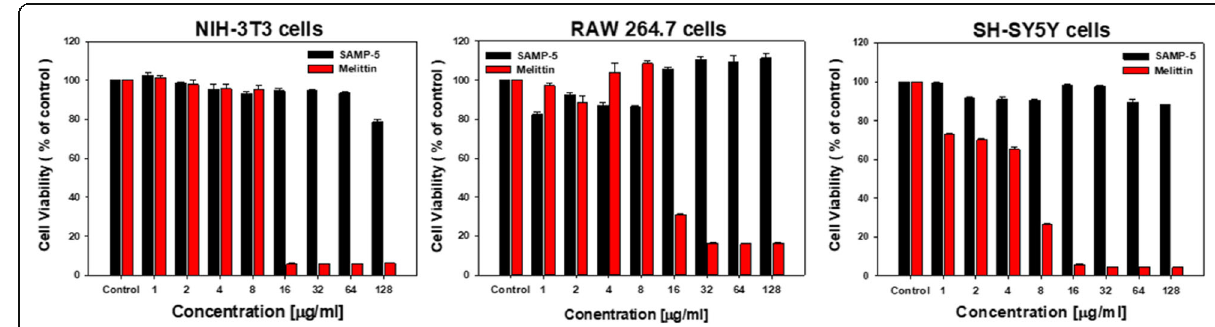
Fig. 2 Cytotoxicity of SAMP-5 against mouse embryonic fibroblast NIH-3T3 cells ( a ), mouse macrophage RAW 264.7 cells ( b ), and human SH-SY5Y bone marrow cells ( c ) determined by MTT